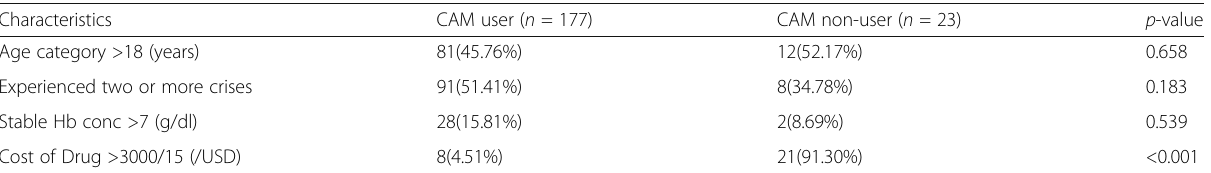
Table 3 Comparison of the age, frequency of crises, haemoglobin concentration and financial burden for medicines between CAM and CAM non-users Characteristics